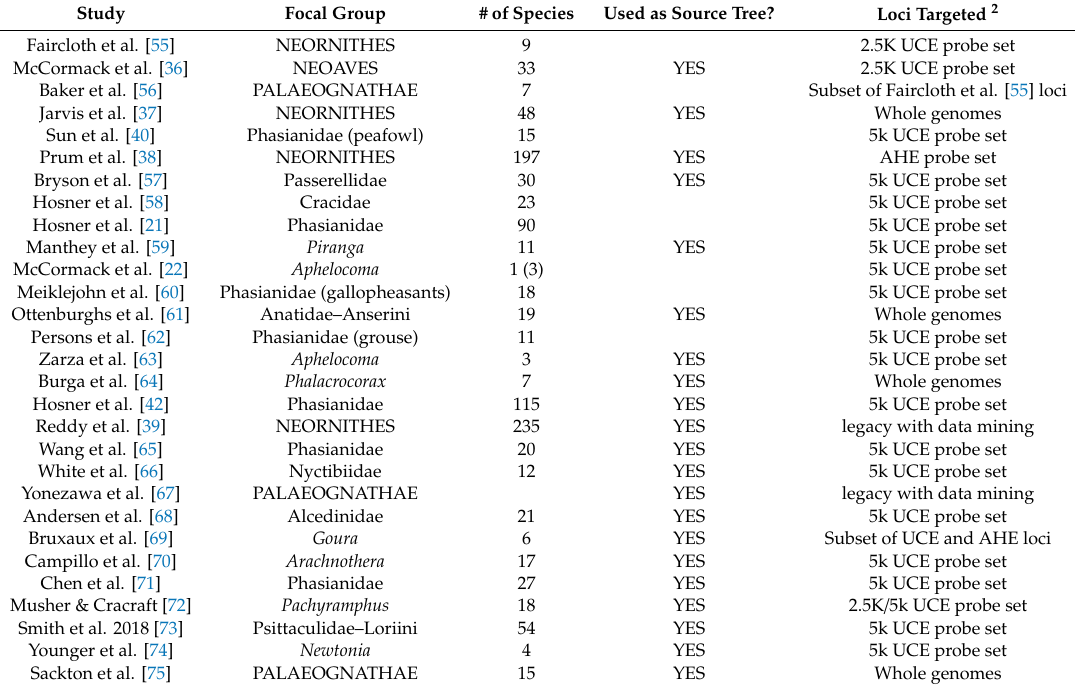
Table 1. Phylogenomic studies of birds considered for use in this supertree 1